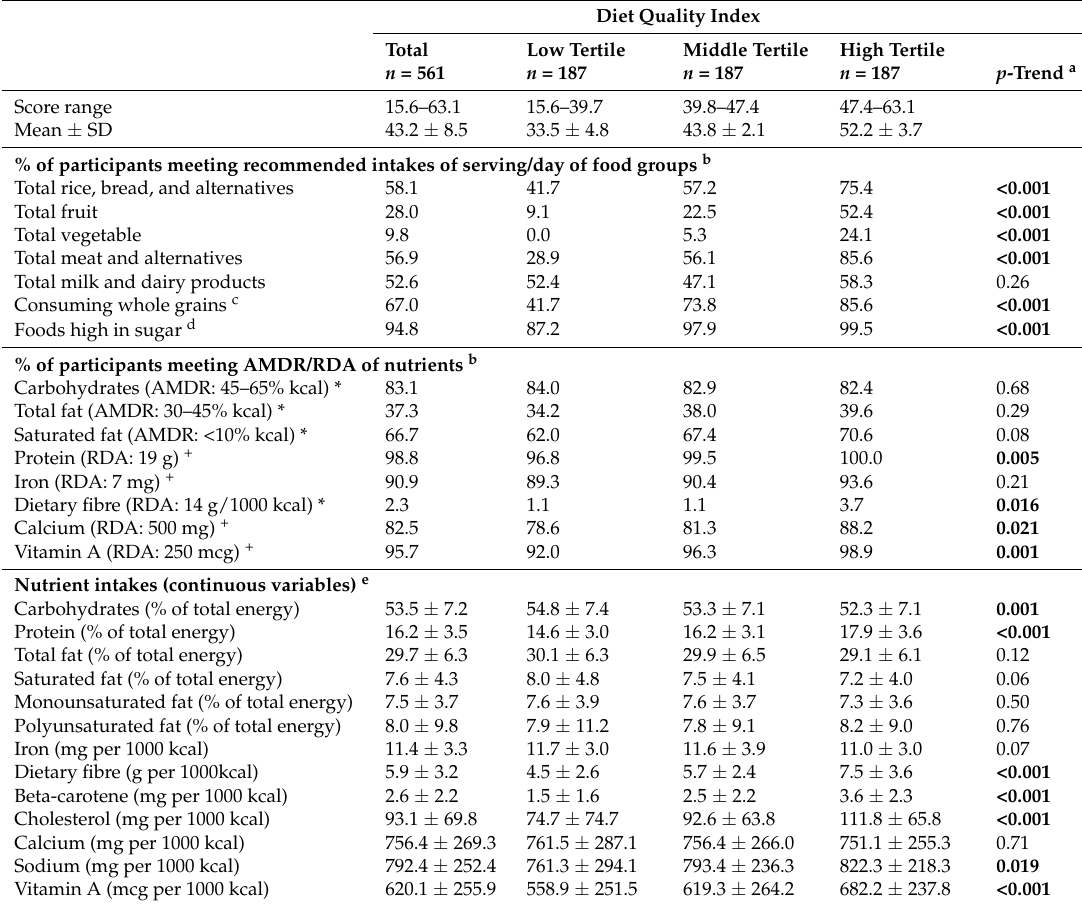
Table 3. Percentages of participants meeting recommended servings of food groups or AMDR/RDA and mean nutrient intakes according to DQI